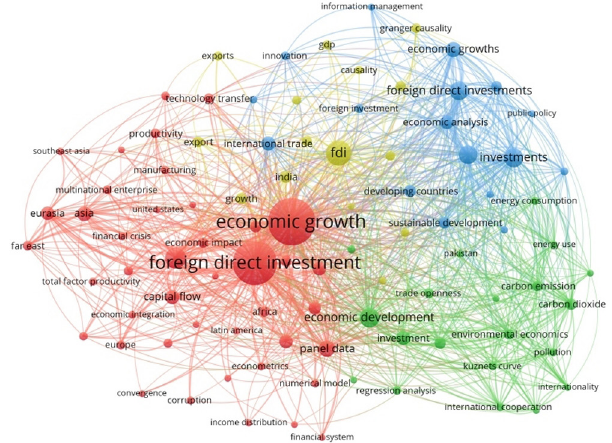
Figure 4. Keywords grouped by clusters (source: Scopus, using